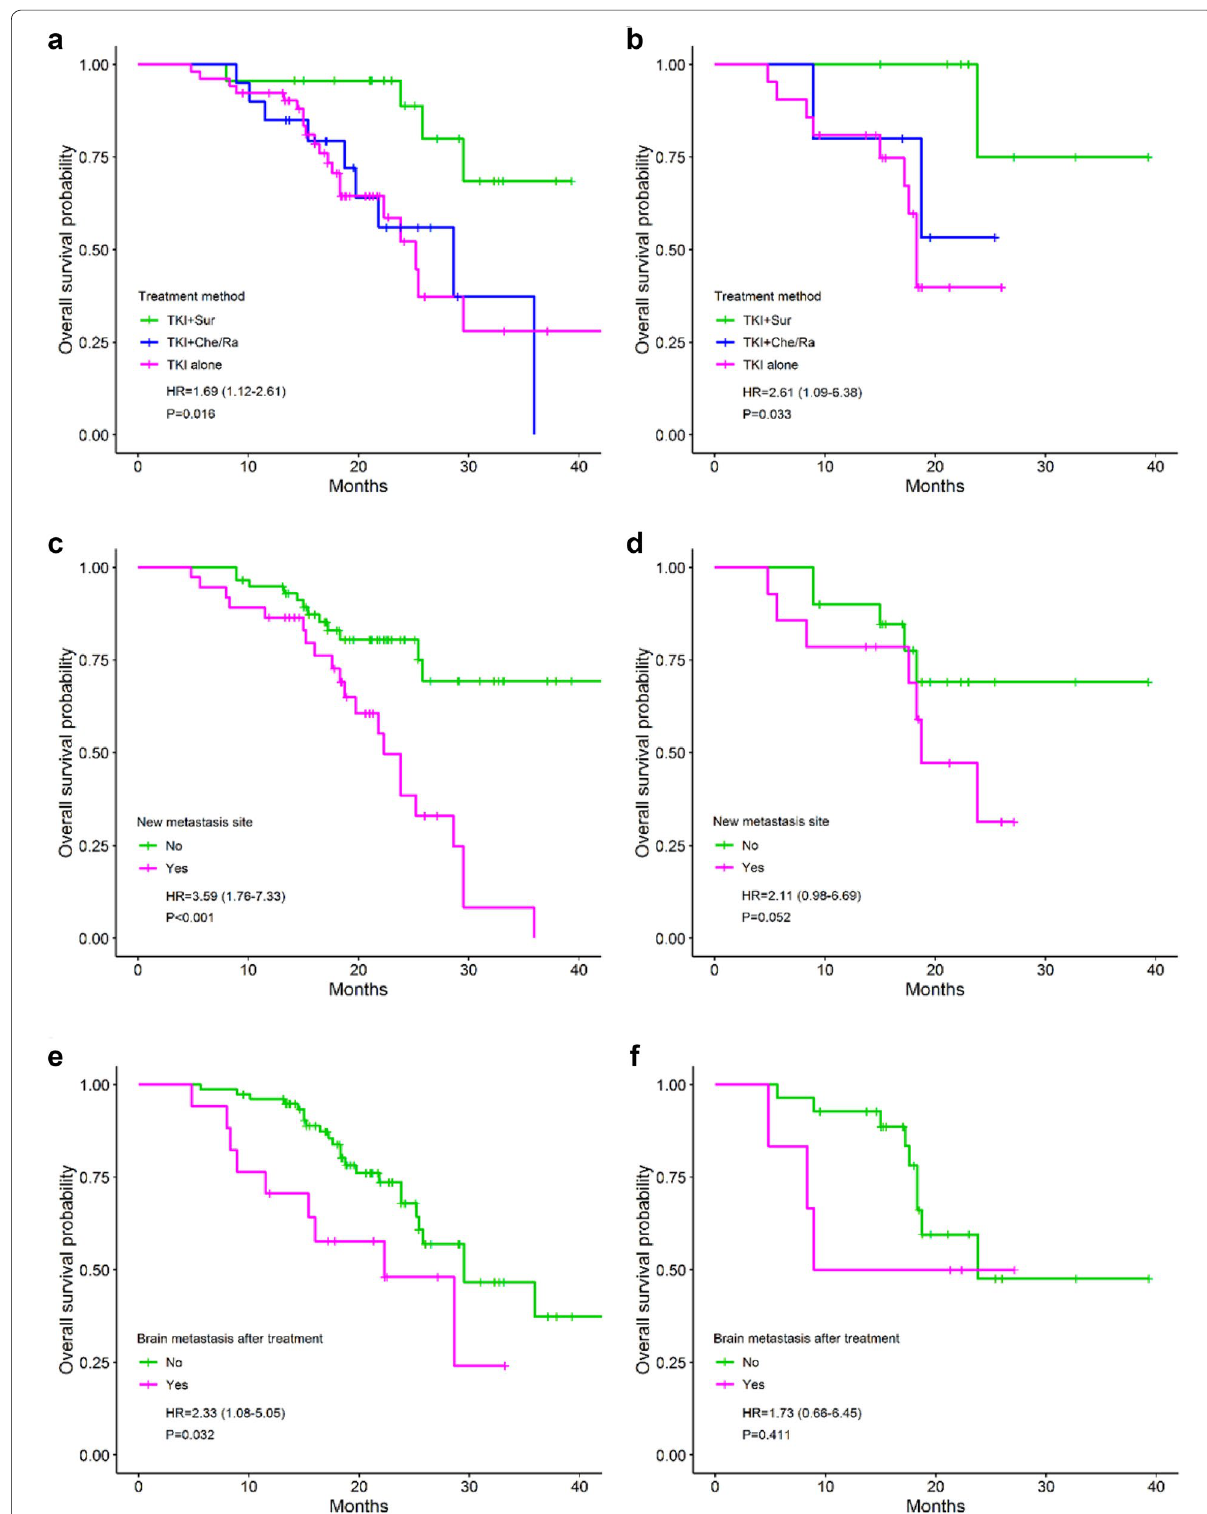
Fig. 6 Overall survival between groups: treatment method ( a £ , b ǂ ); new metastasis site ( c £ , d ǂ ); brain metastasis after treatment ( e £ , f ǂ ). £: all patients; ǂ : the newly diagnosed group. TKI tyrosine kinase inhibitor, Sur surgery, Che chemotherapy, Ra